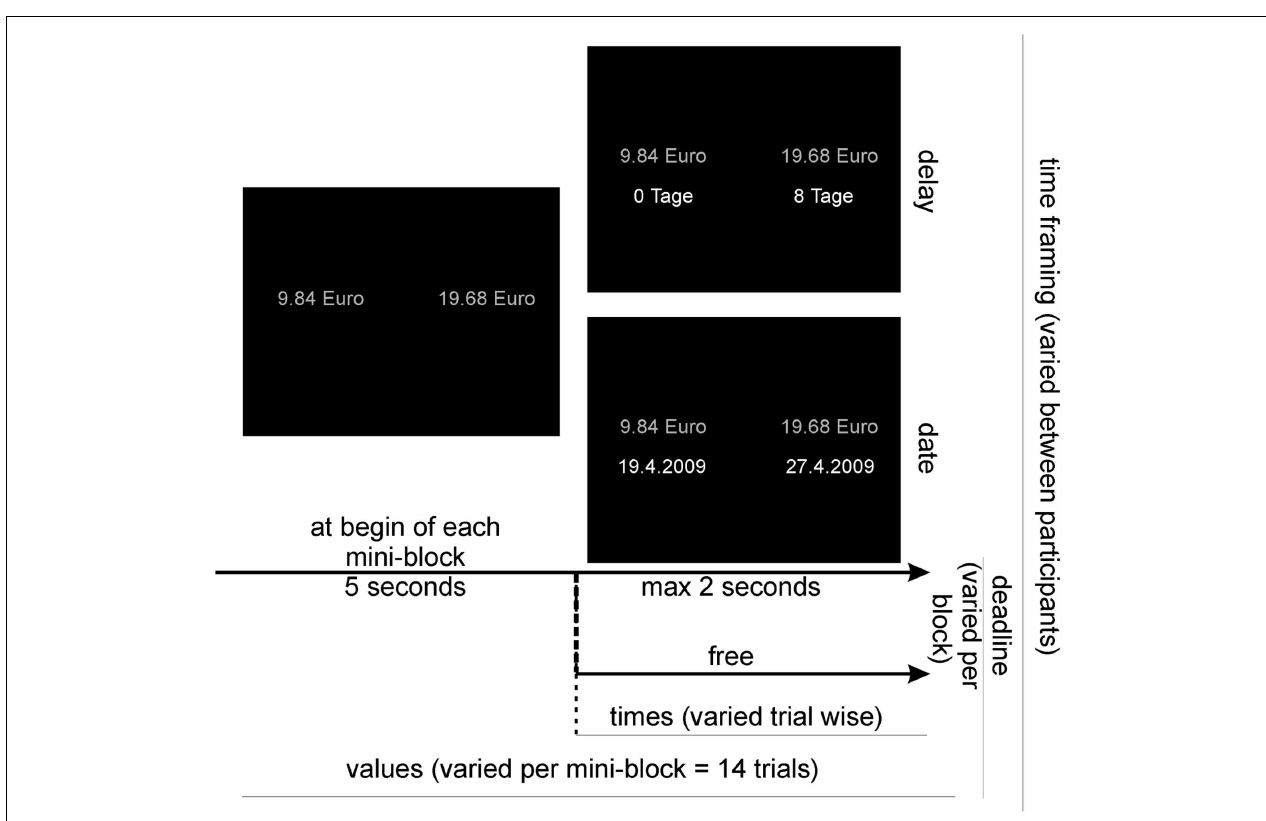
mini-blocks (varying option values), consisting in turn of 14 trials (varying option delays). Before each mini-block, the option values were presented for